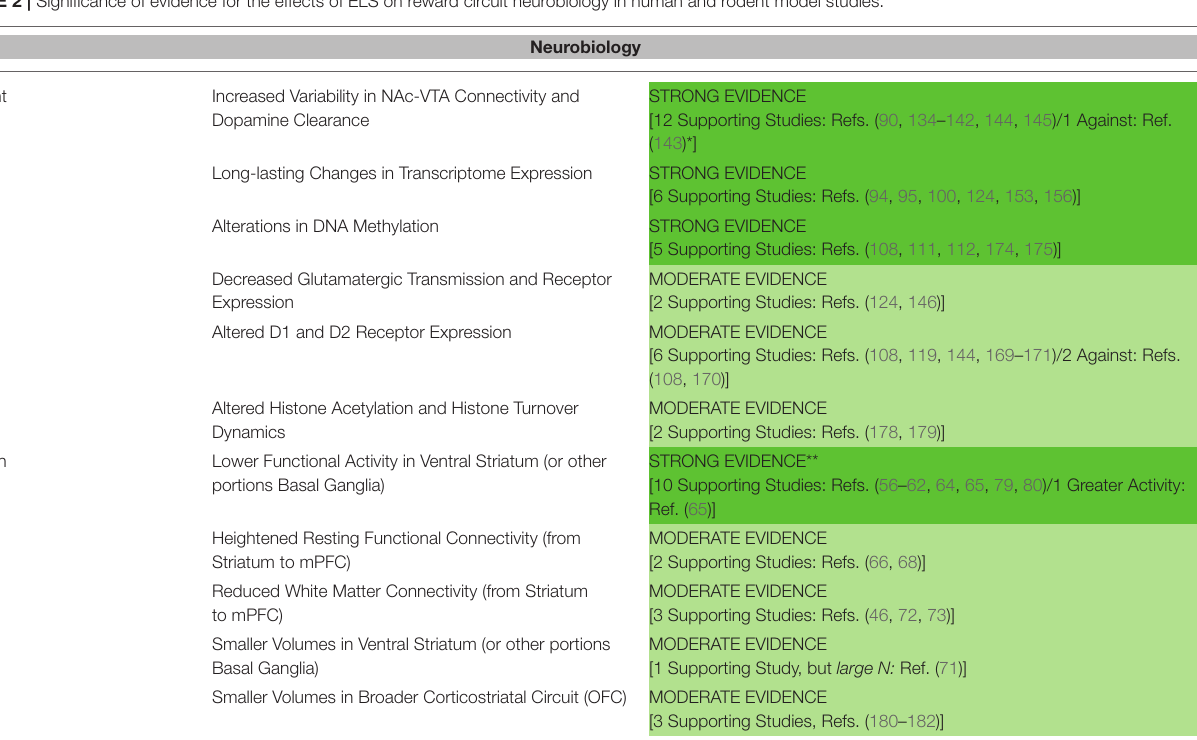
TABLE 2 | Significance of evidence for the effects of ELS on reward circuit neurobiology in human and rodent model